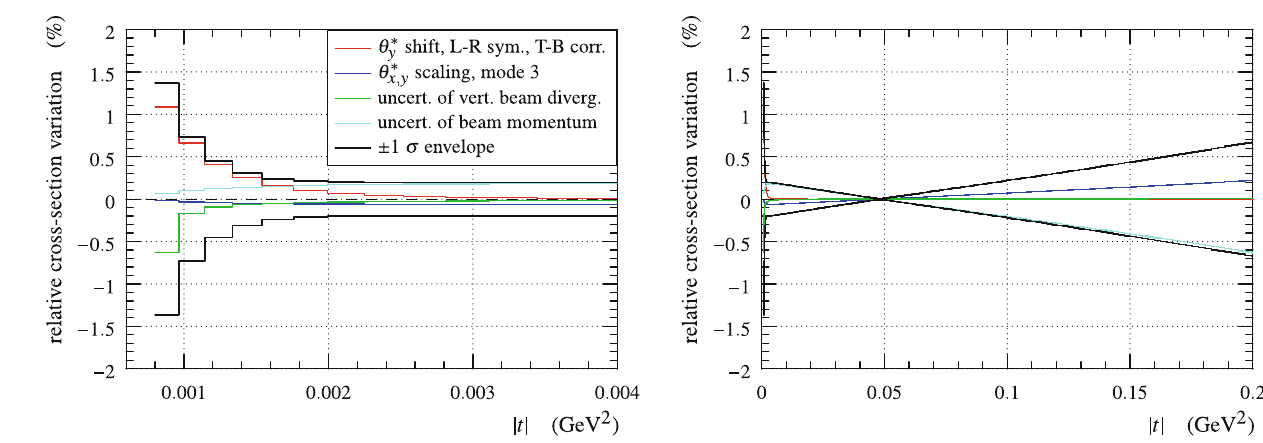
bias, cf. Eq. (12). The envelope is determined by summing all con- sidered contributions (except normalisation) in quadrature for each | t